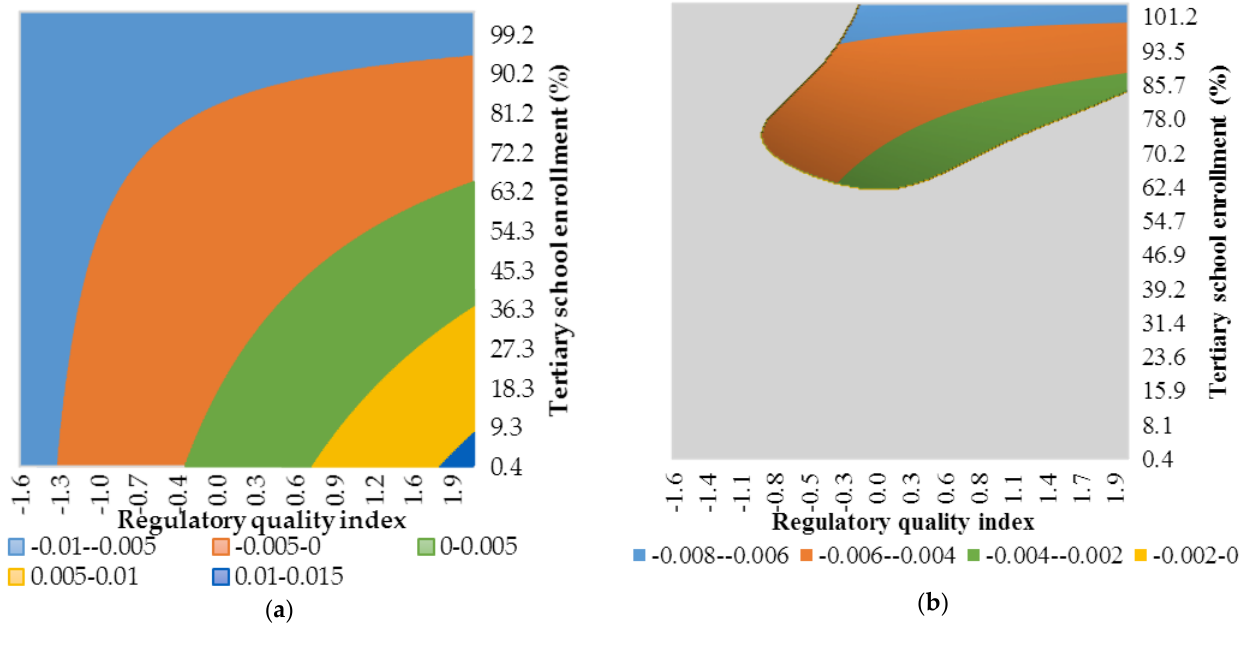
Figure A10. Conditional effect of financialisation on growth based on Est. 10 in Table A2. ( a ) Estimated conditional slope coefficient over the whole range of observed values for institutional quality and development level. ( b ) Estimated statistically significant conditional slope coefficient. Gray represents a combination of institutional quality and development level for which effect of financialisation on growth is statistically insignificant. Source: authors’ contributions.